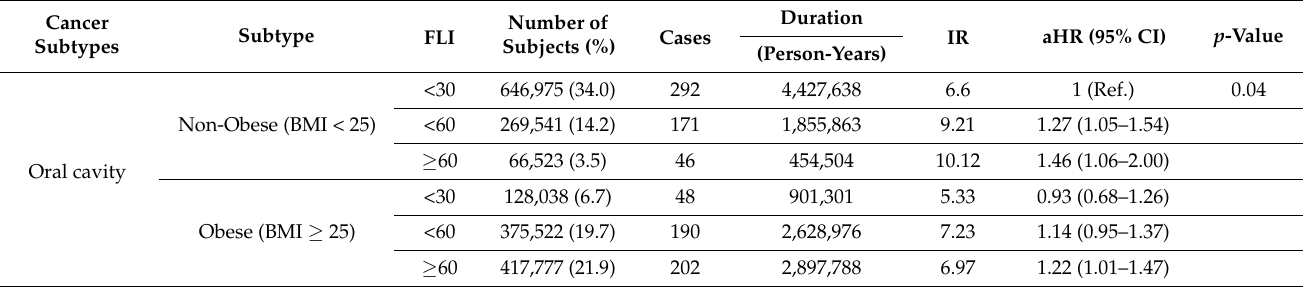
Table 3. The aHR and 95% CI for HNC in DM patients based on the combination of obesity and fatty